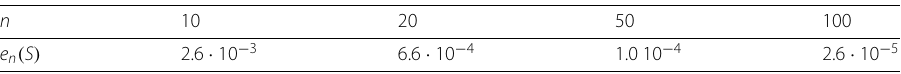
Table 2 Errors for f ( x ) = | x | with the S spline n 10